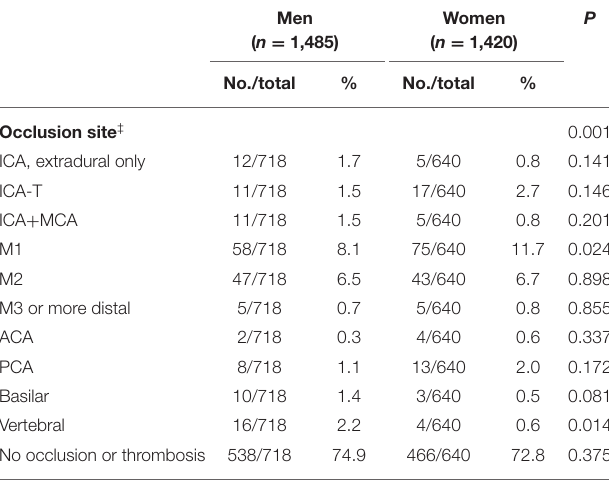
TABLE 2 | Site of occlusion or thrombosis.